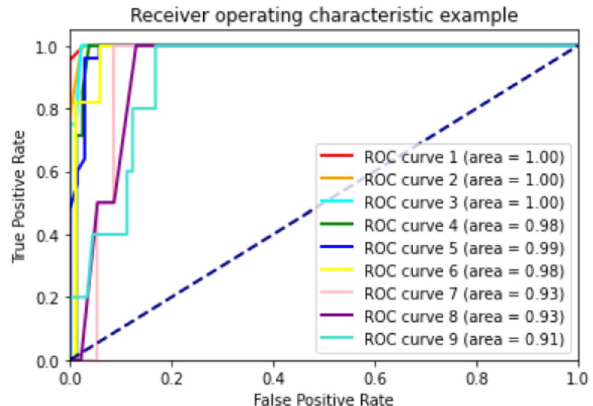
Figure 4. AUROC in RF algorithm for predicting exercise appropriate for healthy men and those with osteopenia and OP.